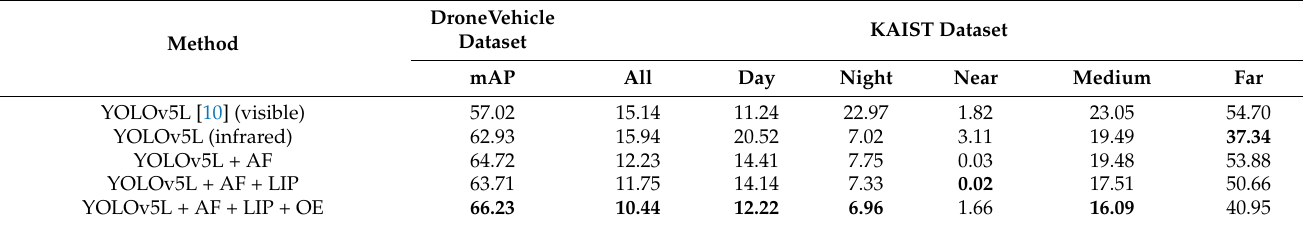
Table 6. Ablation results of adaptive fusion (AF), the local illumination perception (LIP), and offset estimation (OE)